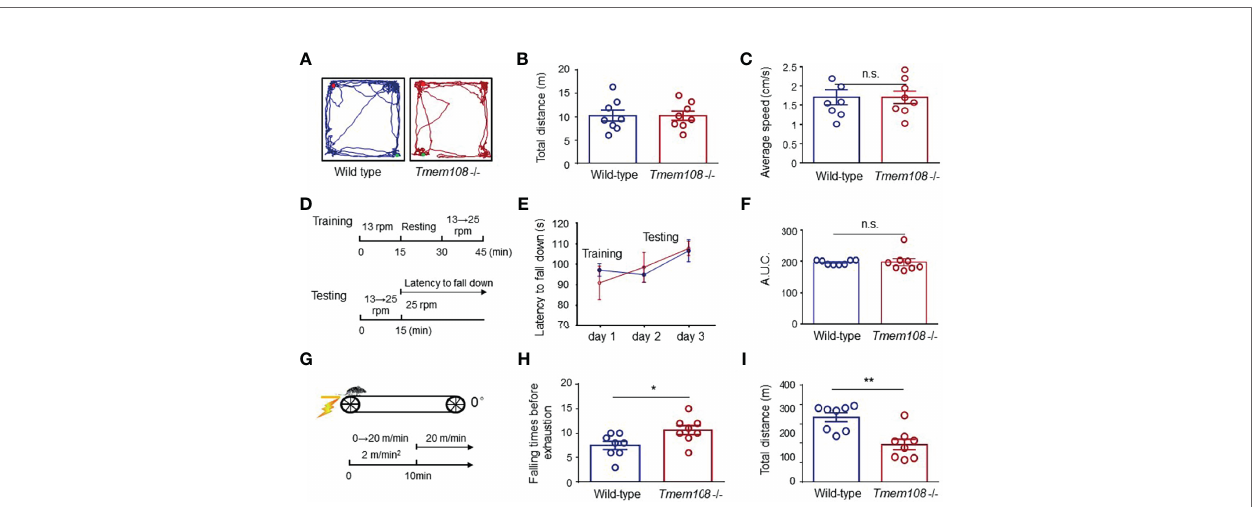
FIGURE 5 | Impaired fatigue resistance of Tmem108 mutant mice without de fi ciency of motor coordination ability. (A) Representative traces of the mice in the open fi eld test. The mouse was placed in a chamber, and the movement was monitored for 10 min (n = 8 per group, male mice). (B) Similar total distance traveled between Tmem108 mutant ( Tmem108 -/-) mice and the control mice (Wild-type). (C) The average movement speed in Tmem108 mutant mice was not different from the control mice. (D) Diagram of the rotarod test. The mouse was put on a rotarod wheel. Day 1 was for acclimation training, and there were two trials each day for training or testing. In the second trial, mice were resumed on the rotarod when they stopped running or fell off 4 times within 60 s of each fall, and the latency to fall was recorded individually (n = 8 per group, male mice). (E) The latency to fall was similar in training or testing days between two types of mice. (F) AUC for the latency to fall (day 1-3) was calculated during the rotarod test. (G) Diagram of muscle fatigue task test. The speed was accelerated with a 2 m/min*min ramp 0 m/ min to 20 m/min. The mice ’ s exhaustion was unable to restart by continuous contact ( ≥ 5 sec) even with the electrical shock (n = 8 per group, male mice). (H) The falling times of mice before exhaustion was recorded individually. (I) The total distance for each mouse was calculated by the product of speed and the corresponding time. (Data are represented as means ± SEM; unpaired t -test, *p < 0.05, **p < 0.01). n.s., not signi fi